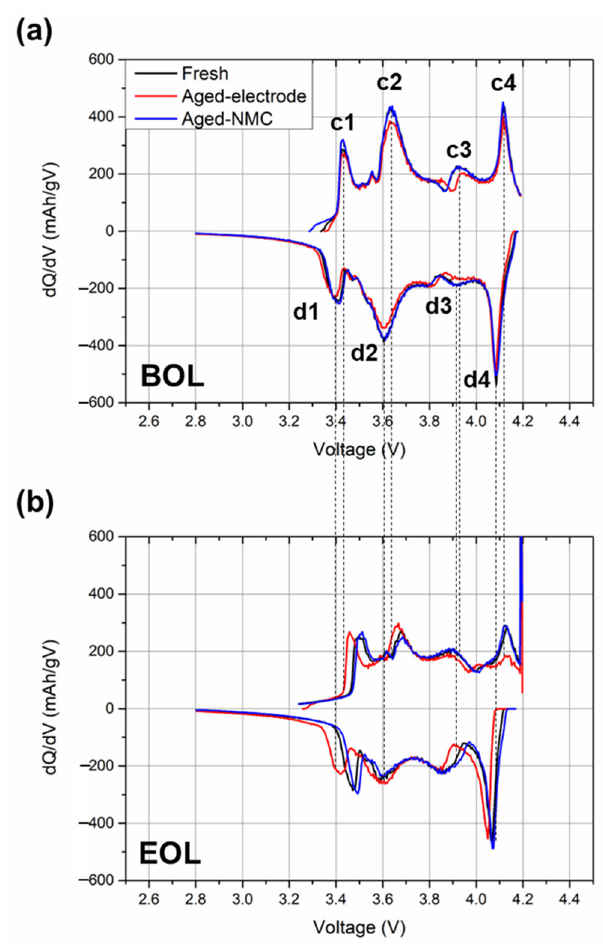
Figure 4. dQ/dV of the cells ( a ) at the beginning and ( b ) end of life performed at C/20 between 2.8 and 4.2 V at C/20. Included cells with fresh (black line), aged-NMC (blue line) and aged-electrode (red line) cathodes. Main features of the scan are labelled as c1, c2, c3, c4, d1, d2, d3 and d4. Dashed lines are included to evidence the overpotential generated for the main signals.